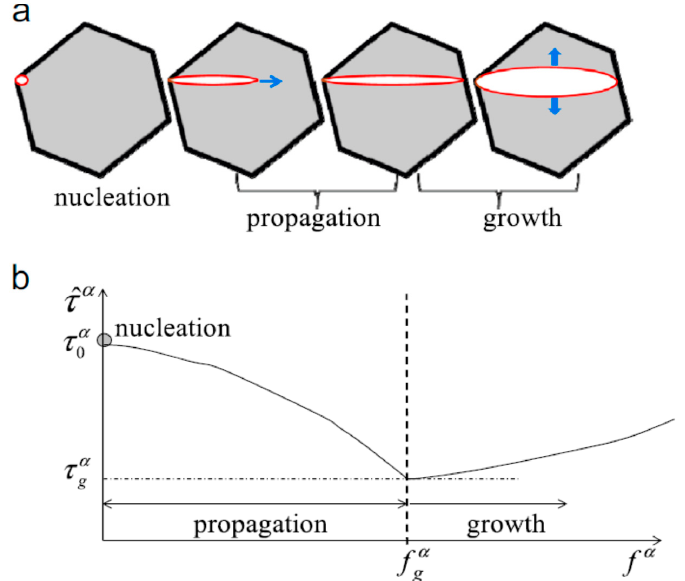
Figure 7. Extension twinning in Mg and its alloys. ( a ) The schematics of extension twin nucleation, propagation, and growth, ( b ) variation of slip resistance for extension twinning system α at different stages of deformation twinning (After Wu et al. [105]).